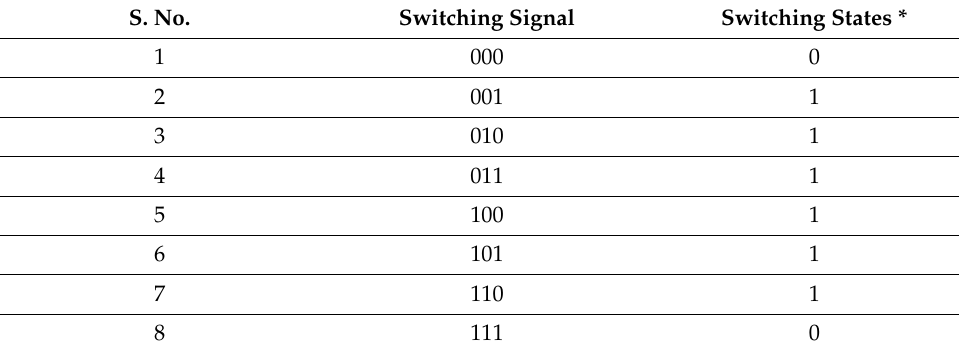
Table 1. Switching of the inverter. S.